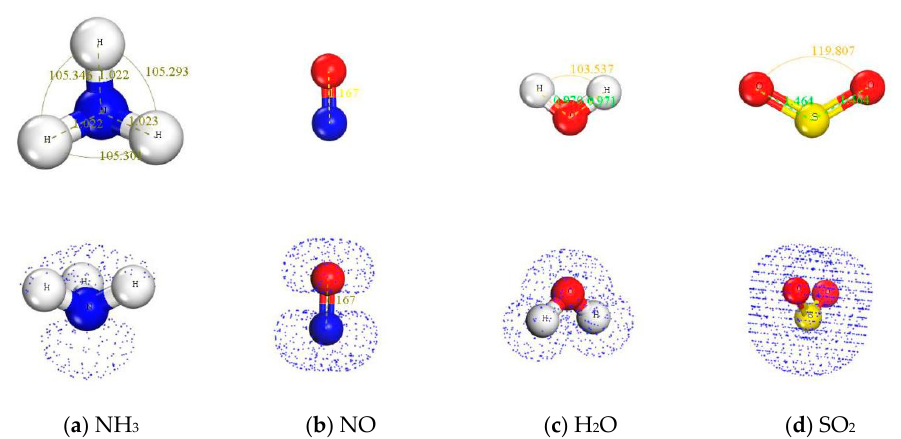
Figure 1. Structure and Fukui’s function of several different gas molecules.